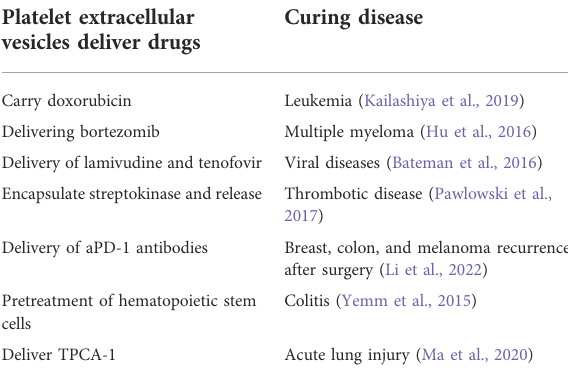
TABLE 2 Drugs delivered by platelet extracellular vesicles and treatment of disease. Platelet extracellular vesicles deliver